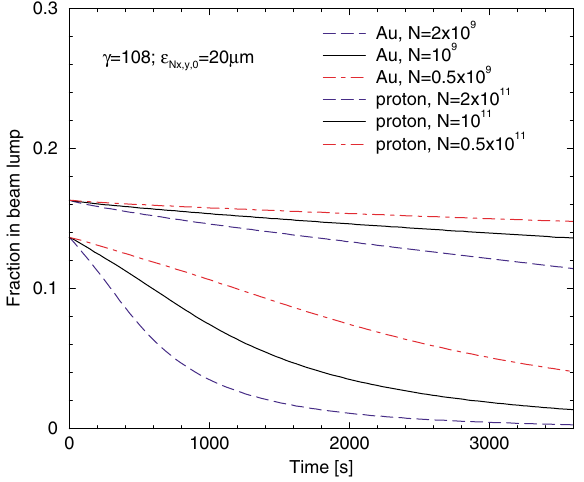
FIG. 17. (Color) Evolution of the fraction of particles in the high density core as a function of time for typical values of Lorentz factor ( (cid:16) ) and 95% normalized transverse emittance ( ? ) during a RHIC store. For protons the design intensity is N (cid:11) 10 11 particles per bunch while there are typically N (cid:11) 10 9 gold ions per bunch. All the proton curves lie above all the gold curves.